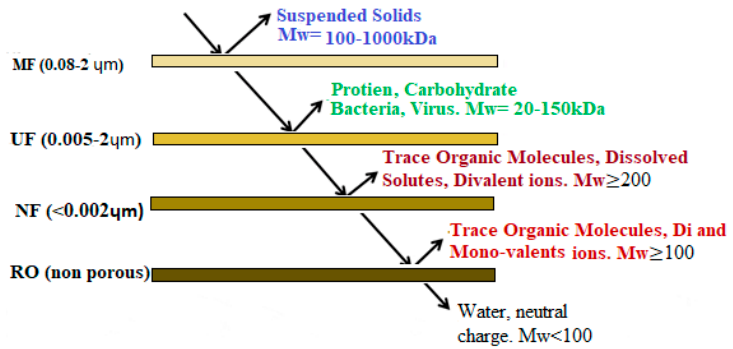
Figure 1. Contaminants rejection by the different type of membrane based on molecular weight.